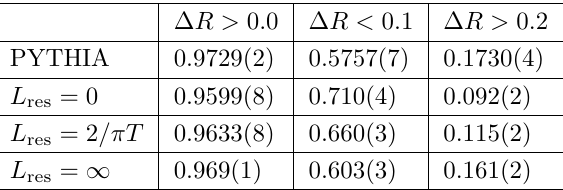
Table 1 . The number of selected jets as a fraction of the total number of jets N jets within the experimental acceptance. The number of selected jets is N jets minus the number of jets that never pass the Soft Drop condition (4.1) minus the number of jets that pass the Soft Drop condition but where the two subjets identi(cid:12)ed after the Soft Drop grooming procedure are separated by an angle (cid:1) R that does not meet the criterion speci(cid:12)ed for each column of the table. The rows of the table give the number of selected jets as a fraction of N jets for jets in vacuum as calculated in PYTHIA p and for jets in PbPb collisions as calculated in the hybrid model at s = 2 : 76 ATeV with three di(cid:11)erent values of the resolution length of the medium.